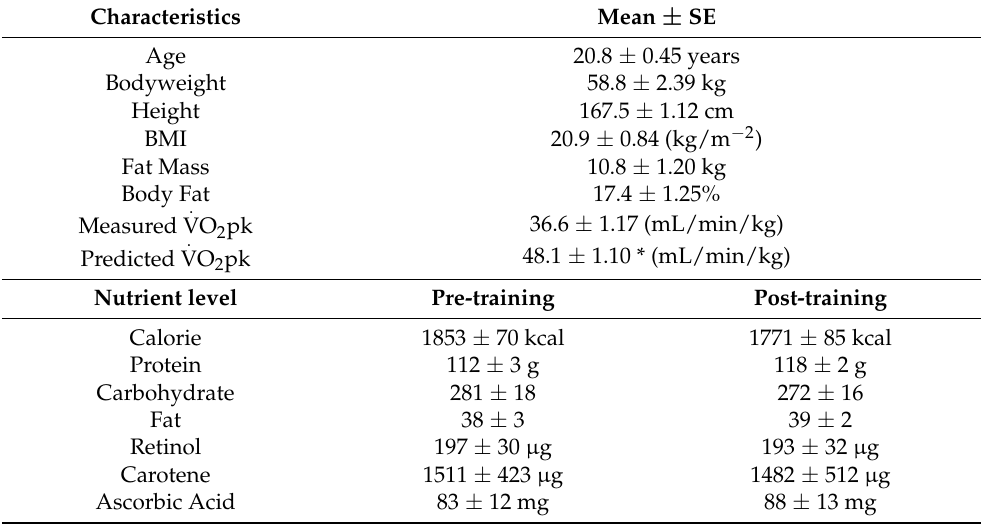
Table 1. Characteristics of all subjects and their nutritional intake pre- and post-training.